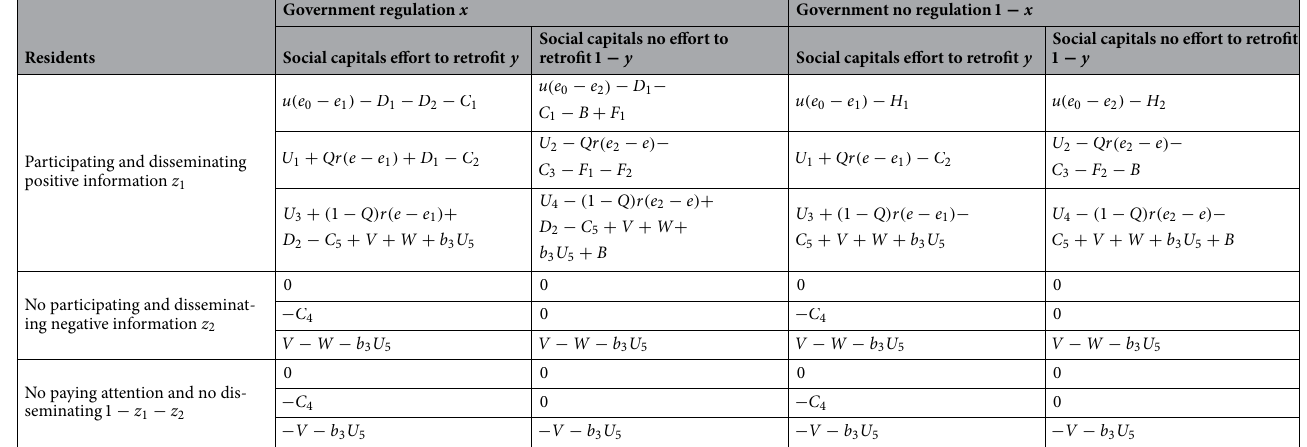
Table 2. Payoffs matrix for the government, social capitals and